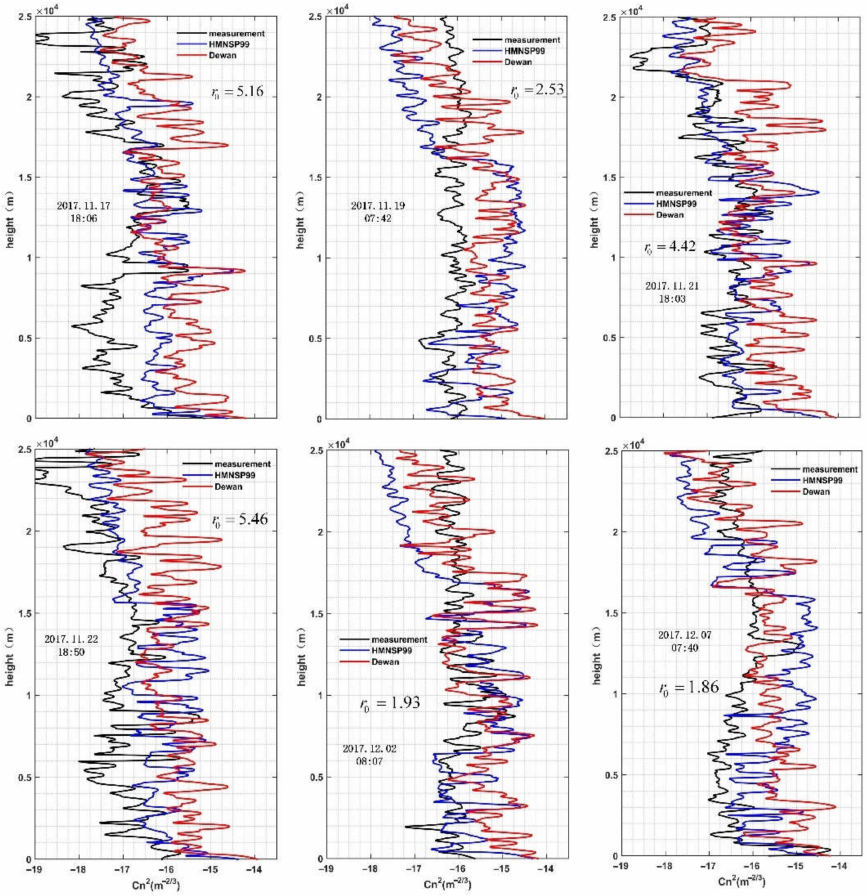
Figure 2. Comparison of C 2 n profiles between measurements by radiosonde and estimations by HMNSP99 and Dewan